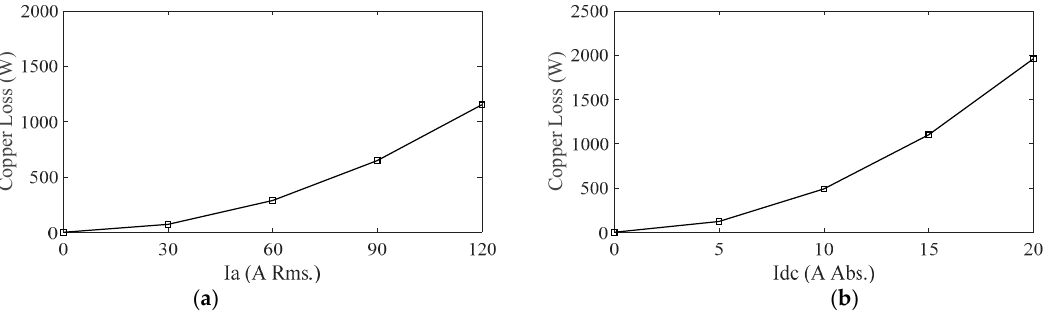
Figure 11. Evolution of copper losses as winding currents under different PRs. ( a ) The copper loss of armature windings. ( b ) The copper loss of DC field windings.